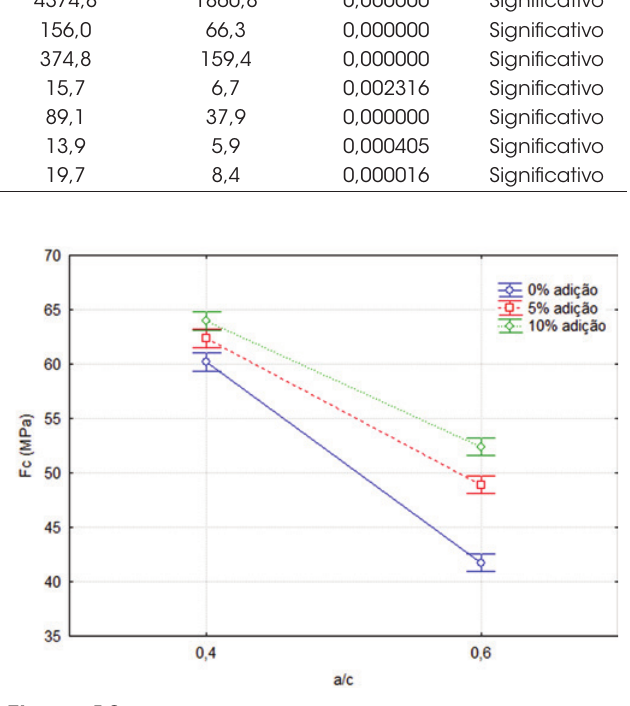
Influência da interação entre a relação